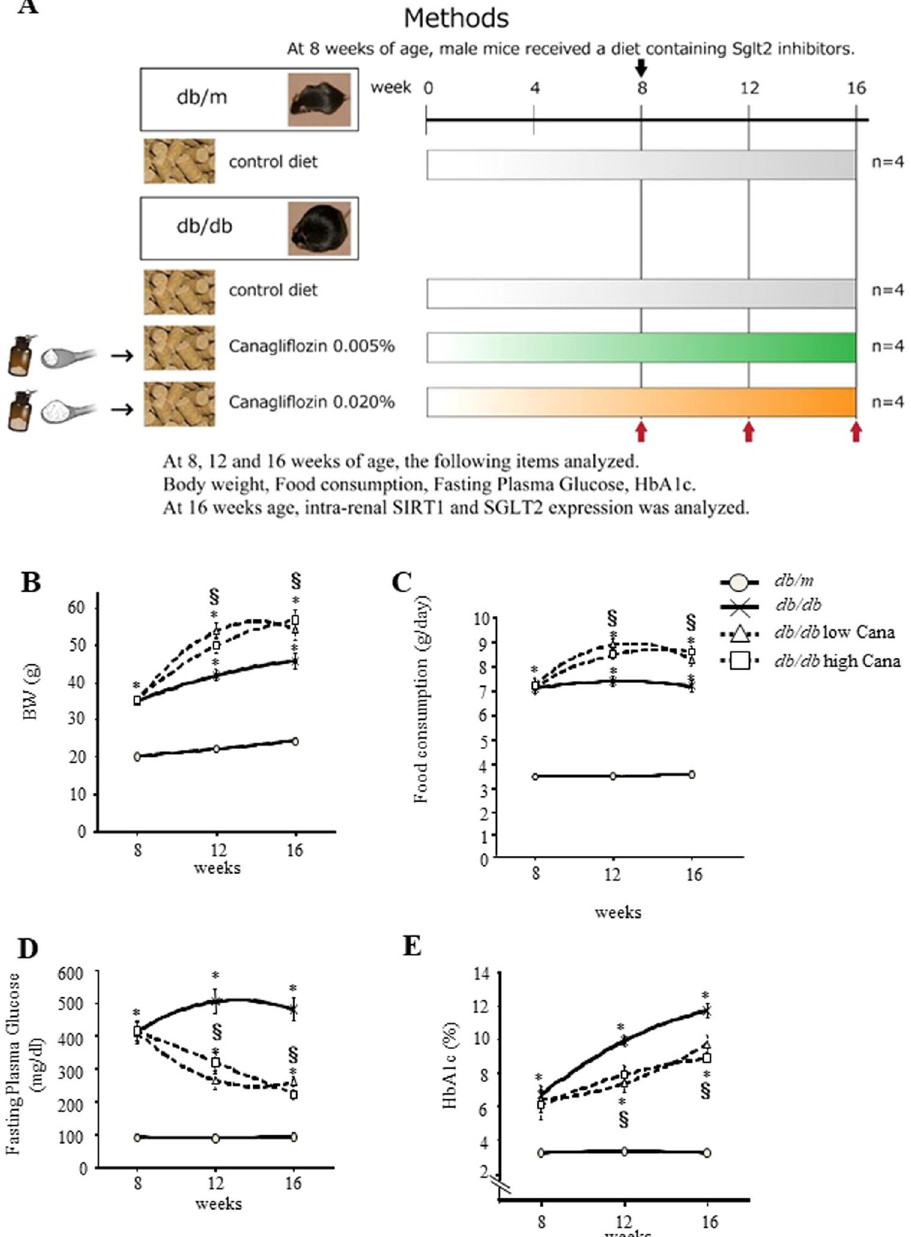
Figure 1. Effect of canagliflozin on parameters of glucose metabolism. ( A ) Schedule for canagliflozin (Cana) treatment and experimental groups. Effects of Cana on body weight ( B ), food intake ( C ), fasting plasma glucose level ( D ) and glycated Hb levels ( E ) in db / db mice. HbA1c, hemoglobin A1c. Data represent the mean ± SEM ( n = 8 mice/group). * P < 0.05 vs. db / m and § P < 0.05 vs. db / db